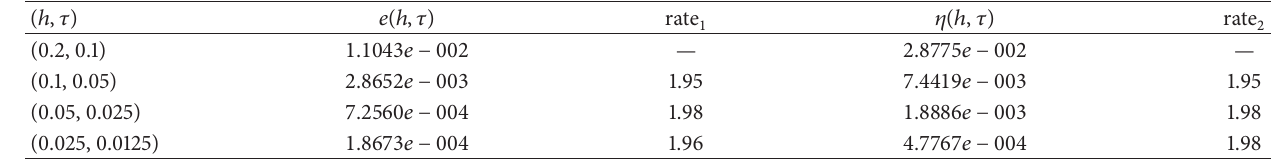
Table 1: Errors and rates of convergence for Scheme A with different ℎ and 𝜏 at time 𝑇 = 1 .